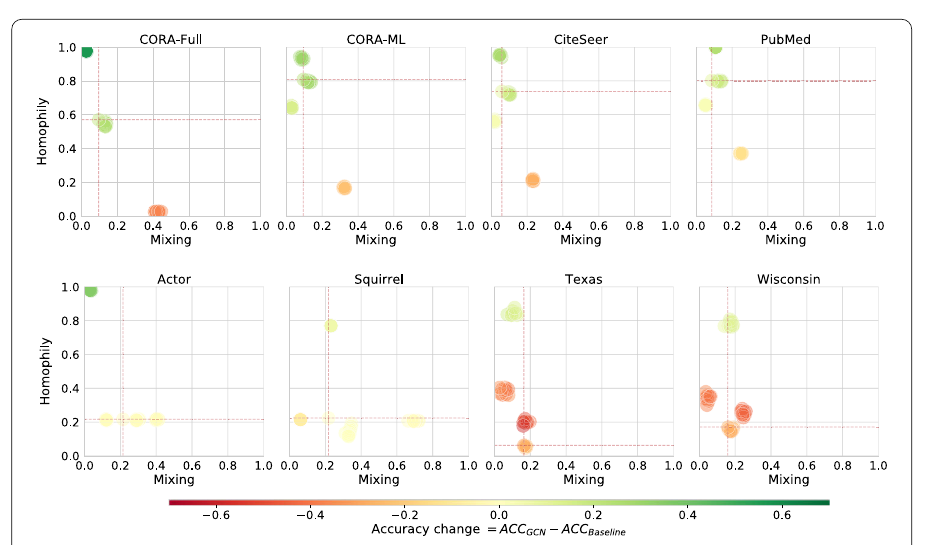
Fig. 11 Homophily and mixing impact on SGC